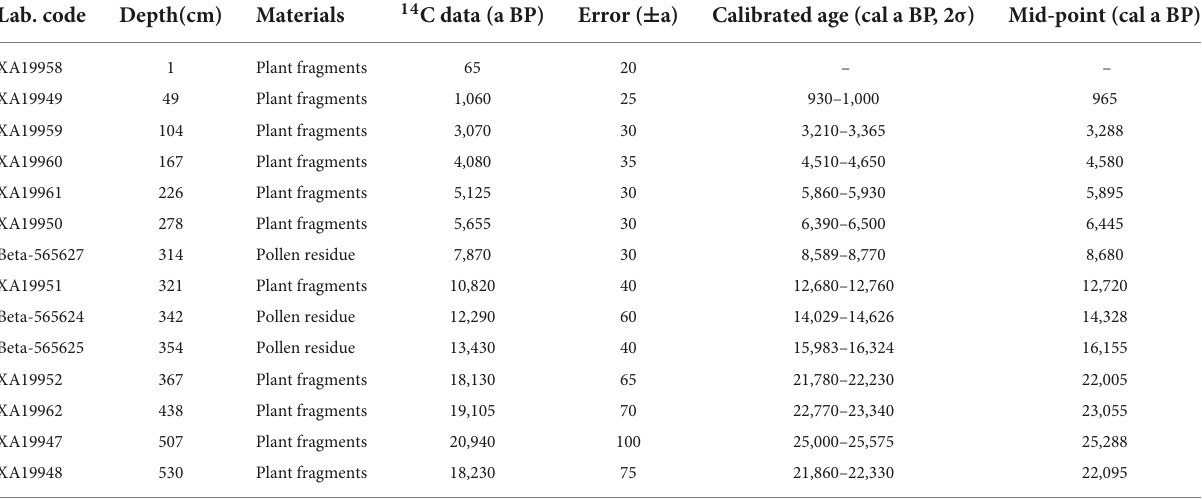
TABLE 1 AMS 14 C dating results of the GC core. Lab.